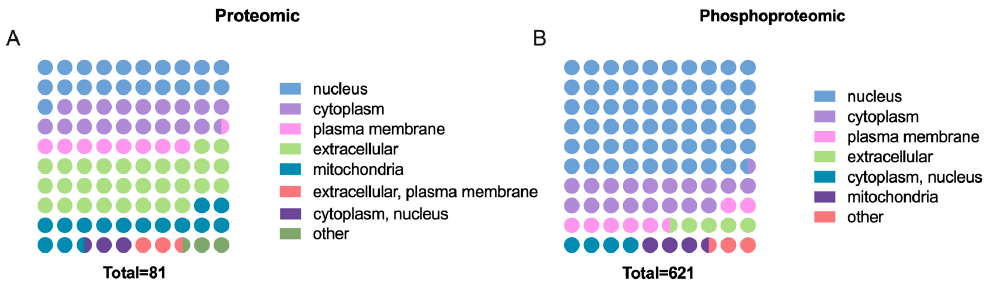
Figure 4. Classification of subcellular structural localization. The subcellular structural localization of DEPs ( A ) and DEPPs ( B ) was predicted and classified statistically by GO annotation.